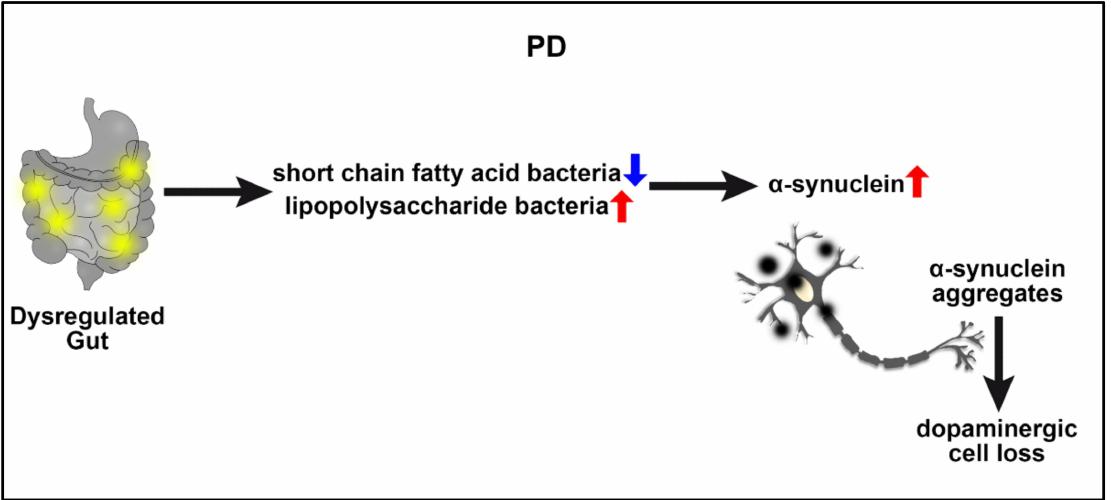
Figure 3. PD and GBA. Prior to dopaminergic depletion in the brain and even before the manifestation of PD symptoms, preclinical and clinical evidence indicates a dysregulated gut characterized by downregulated short-chain fatty acid bacteria but upregulated lipopolysaccharide bacteria, resulting in abnormal accumulation of α -synuclein in the gut that subsequently aggregates in the brain and causes dopaminergic degeneration, a PD pathological